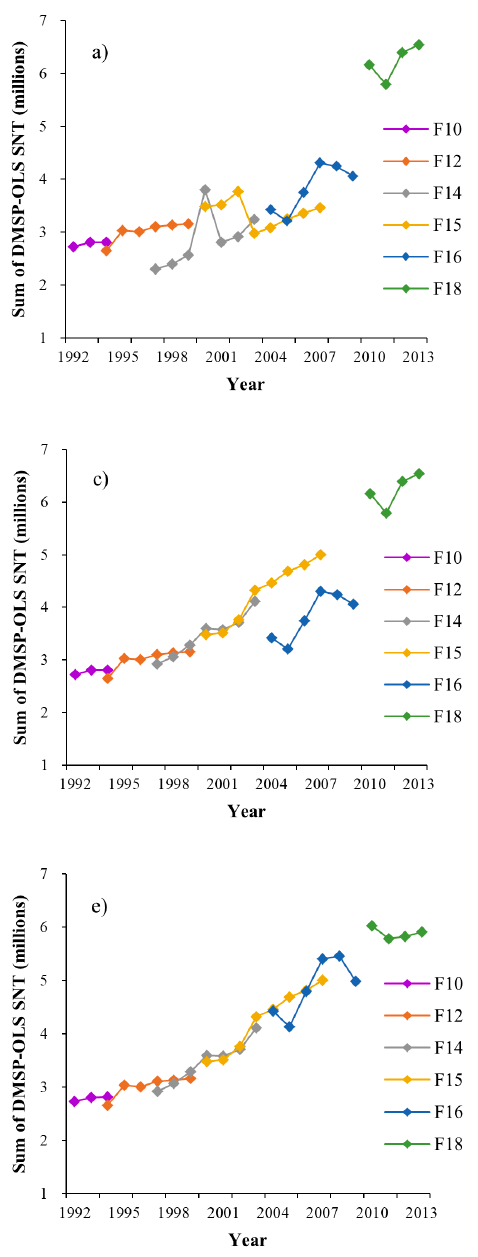
Figure 4. Sum of DMSP-OLS SNT in the stepwise calibration: ( a ) original data before calibration; ( b ) correction of satellite F14; ( c ) adjustment of satellite F15; ( d ) correction of satellite F16; ( e ) correction of satellite F18.